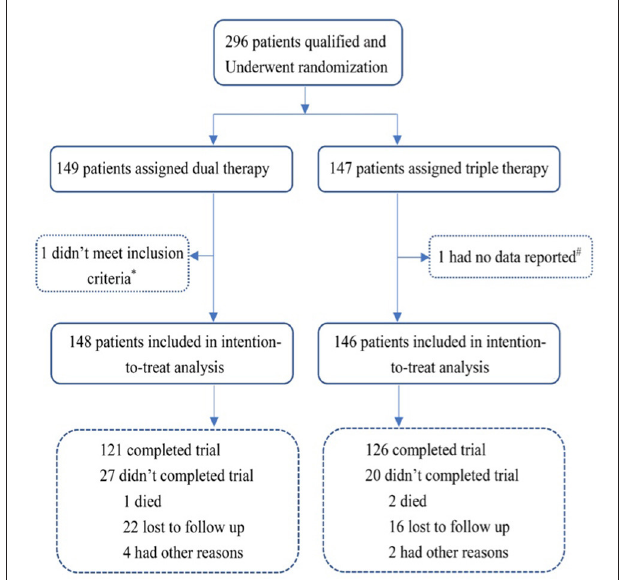
FIGURE 1 | Randomization and follow-up. *One patient in the ticagrelor therapy group did not meet the inclusion criteria immediately after randomization; #one patient in the Triple therapy group had no data reported. Dual therapy: ticagrelor therapy group; Triple therapy: clopidogrel plus aspirin